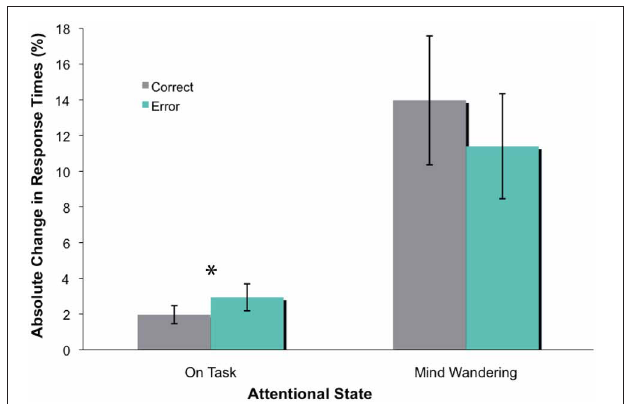
FIGURE 2 | The absolute change in time estimate (in percentage), with standard errors. There was a significant difference between absolute change in time estimate following error and correct feedback during on-task states (as indicated by ∗ ), but not mind wandering